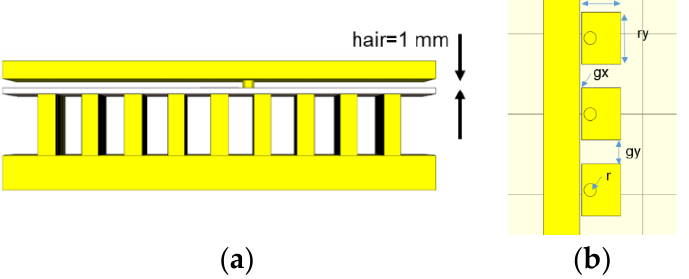
Figure 10. Details of the models used for the simulations: ( a ) Front view of the parallel plate with the thickness of the air layer ( b ) Main design parameters of the EBG filter.